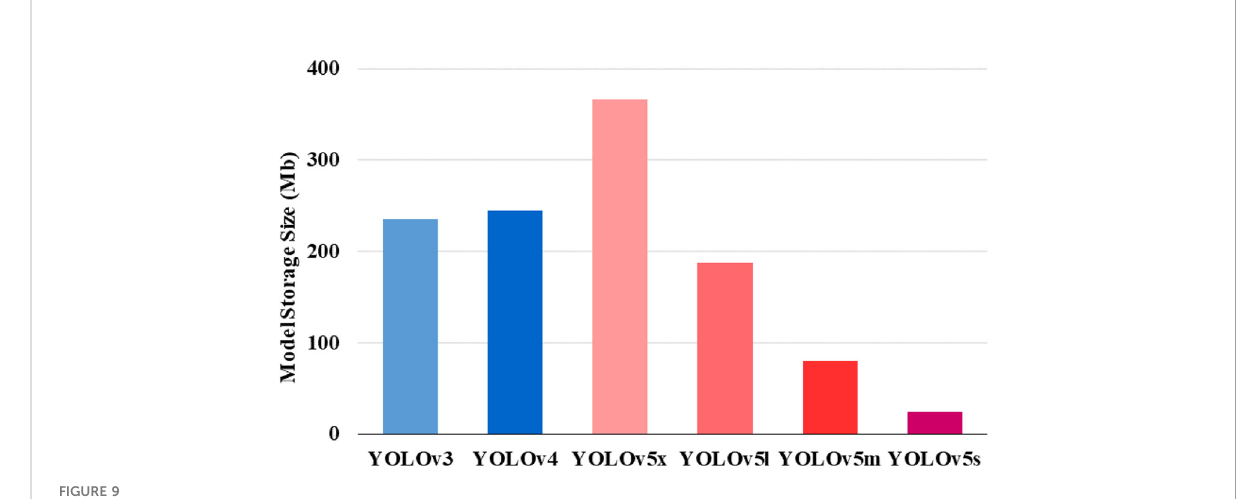
FIGURE 9 Comparison of the size of various